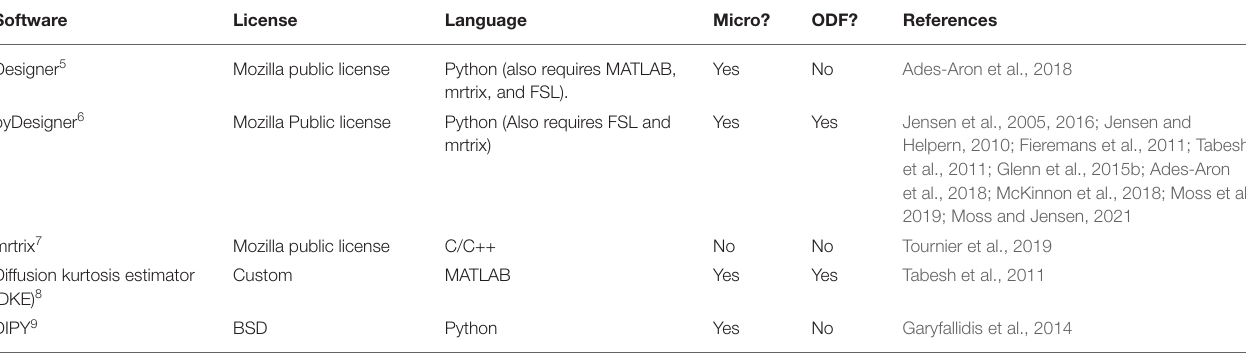
TABLE 2 | Some freely available software libraries that implements